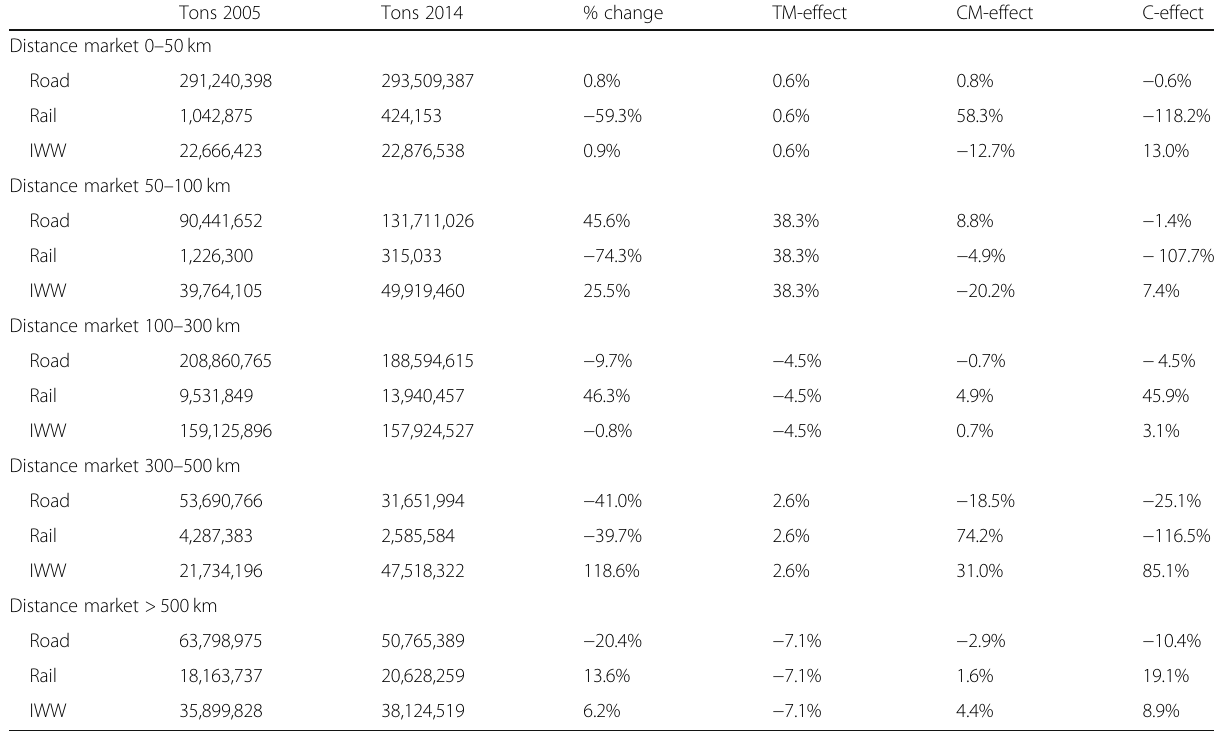
Abbreviations CCNR: Central Commission for Navigation on the Rhine; CGE model: Computable General Equilibrium model; CO 2 : Carbon